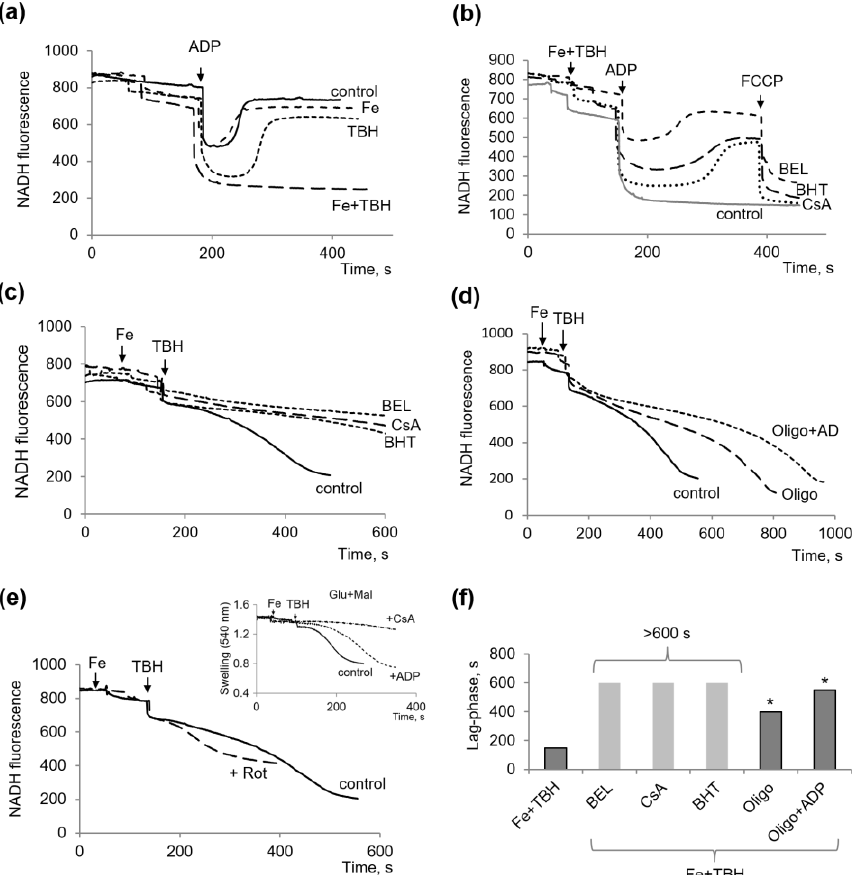
Figure 3. Influence of TBH and ferrous ions on the oxidative phosphorylation measured by NADH fluorescence during oxidation glutamate with malate. Influence of ferrous ions, TBH, and their together on ADP-stimulated changes in the NADH redox state ( a ); the influence of BEL (50 µ M), BHT (20 µ M), and CsA (1 µ M) on oxidative phosphorylation ( b ) and NADH oxidation ( c ) in the presence of TBH with ferrous ions; the influence of oligomycin (1.5 µ M), its combination with ADP (100 µ M) ( d ) and rotenone (1 µ M) ( e ) on NADH oxidation induced by TBH and ferrous ions; the influence of ferrous ions and TBH on the swelling induction during glutamate with malate oxidation ( e , insert); comparison of the protective effects of inhibitors on the duration of the lag phase preceding the fall in NADH induced by TBH and ferrous ions ( f ). Asterisk (*) indicates values that differ significantly from the control values ( p <